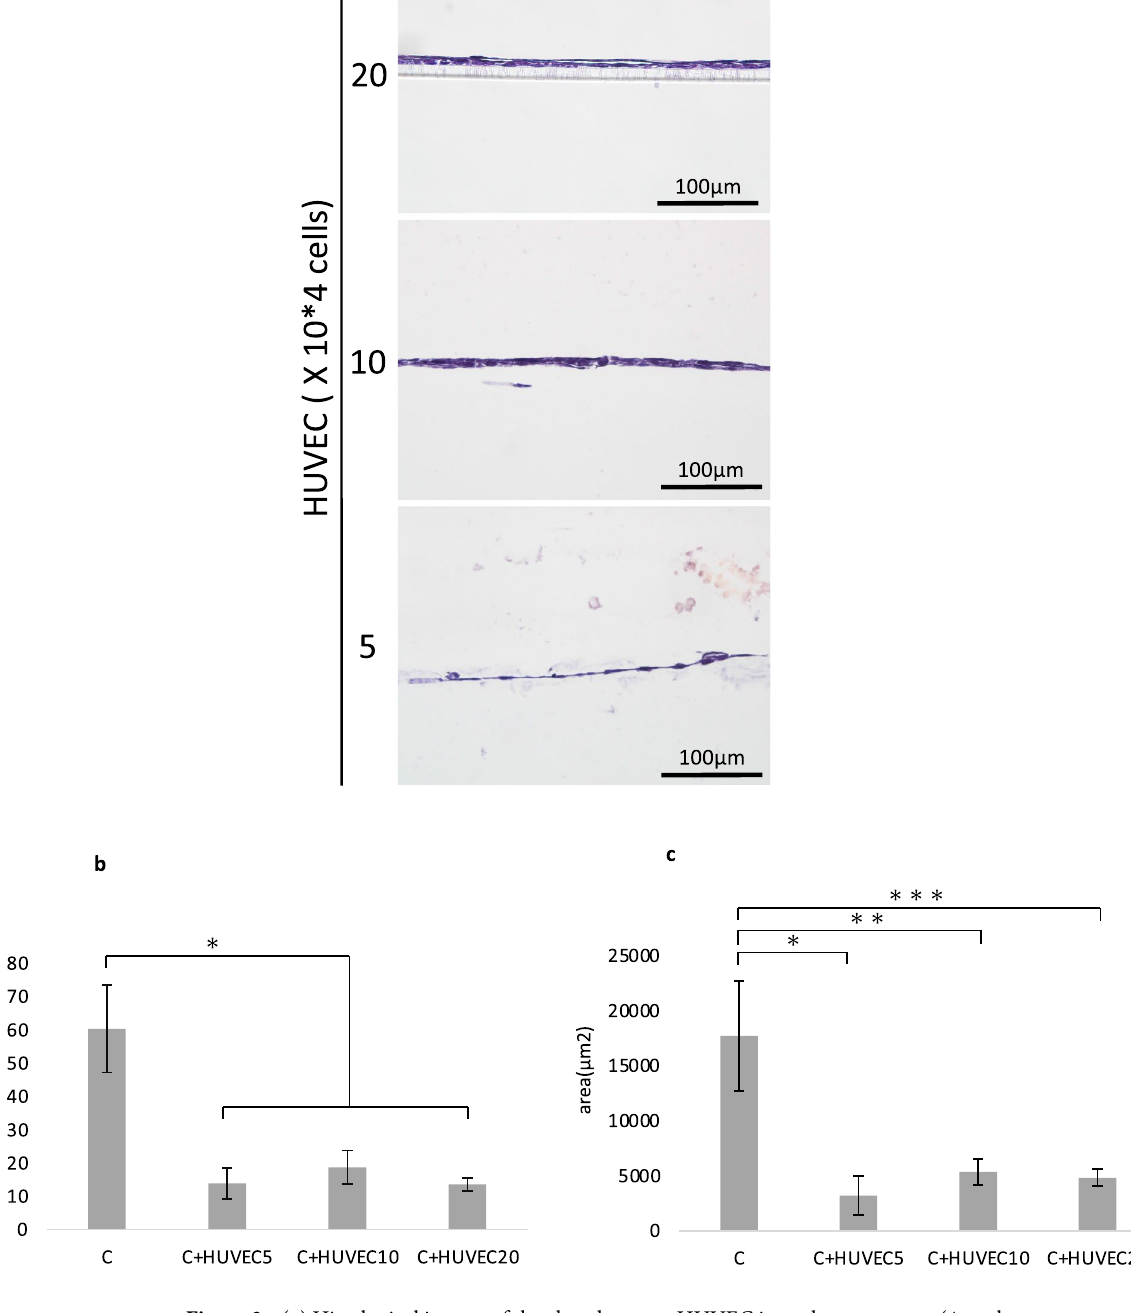
Figure 3. ( a ) Histological images of the chondrocyte + HUVEC inner bottom group (4 weeks posttransplantation, HE staining). Cartilage matrix was not observed in any group. ( b , c ) Statistical analysis of the thickness and area of chondrocytes alone and chondrocytes + HUVECs in the bottom group. The data are shown as the means ± S.D. n = 3. ( b ) Comparison of the thickness. *p < 0.001. ( c ) Comparison of the area. *p = 0.00105, **p = 0.00244, ***p = sections were incubated with primary antibody (F4/80; 1:100 dilution, iNOS; 1:250 dilution) over night at 4 °C and fluorescent secondary antibodies (1:500 dilution) for 30 min at room temperature. For the double staining with the F4/80 and the Arginase I antibody (sc-20150, Santa Cruz Biotechnology), after antigen retrieval and